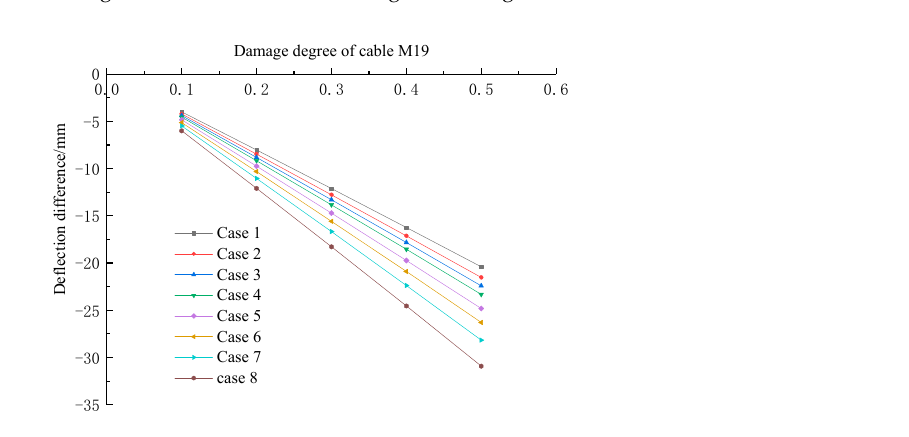
Figure 12. The variation curve of the peak of the deflection difference of the girder with the damage degree of cable M19 when the stiffness of the girder changed.